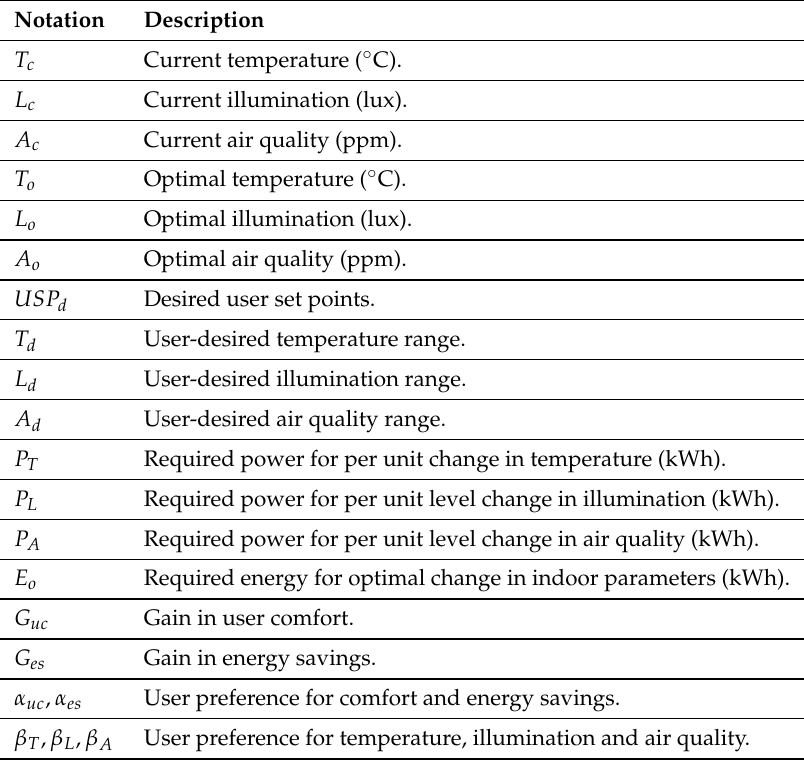
Table 1. Description of notations used in the